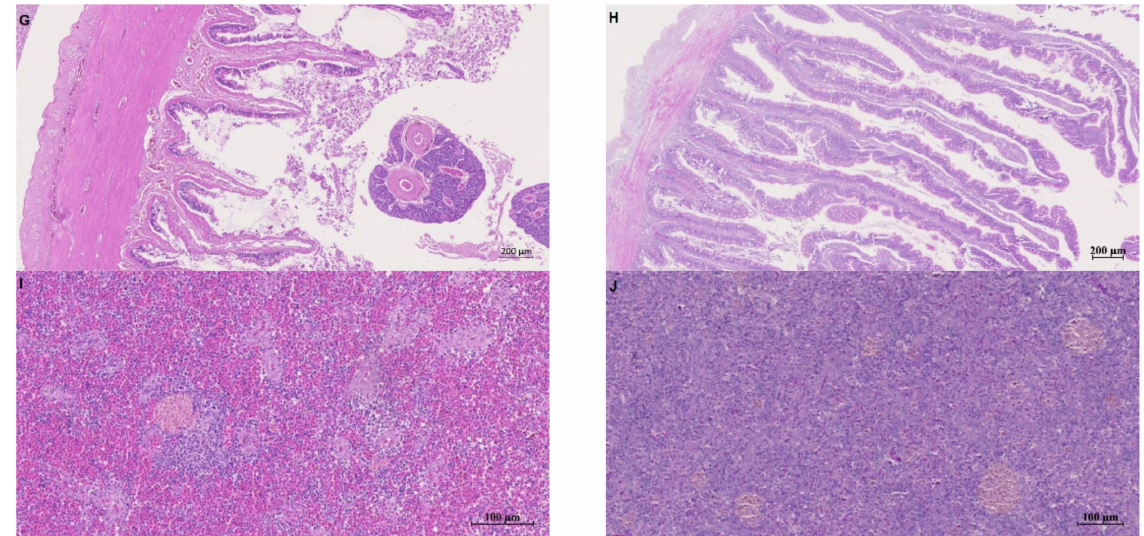
Figure 3. Histopathological changes in tissues of the wild-caught (( A )—gills; ( C )—caudal kidney; ( E )—liver; ( G )—intestine; ( I )—spleen) and the farmed (( B )—gills; ( D )—caudal kidney; ( F )—liver; ( H )—intestine; ( J )—spleen) turbot Scophthalmus maximus